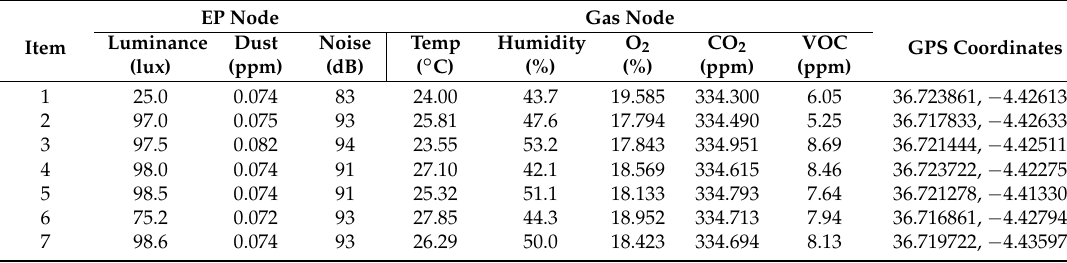
Figure 12. Area of the city center covered by experiments in local mode. Table 1. Data obtained for a city center route in local mode.